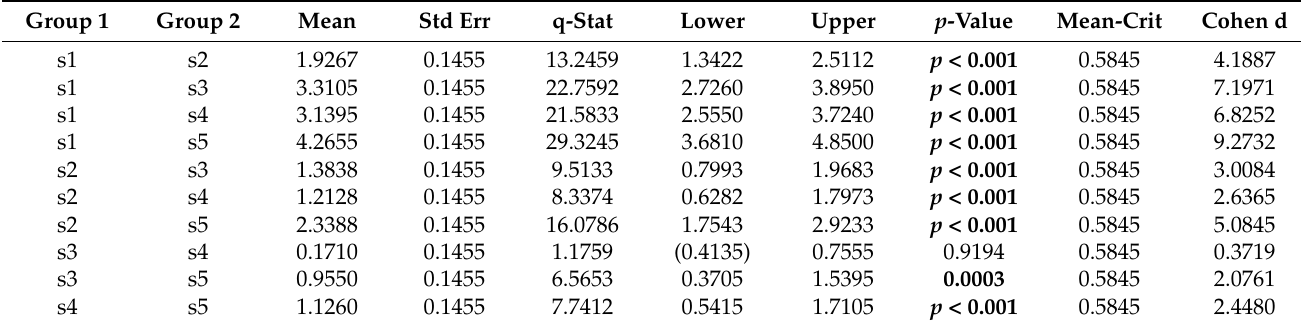
Table A6. Tukey’s HSD Post Hoc Test results regarding ResNet50 (cid:48) s test accuracies of various training set sizes.